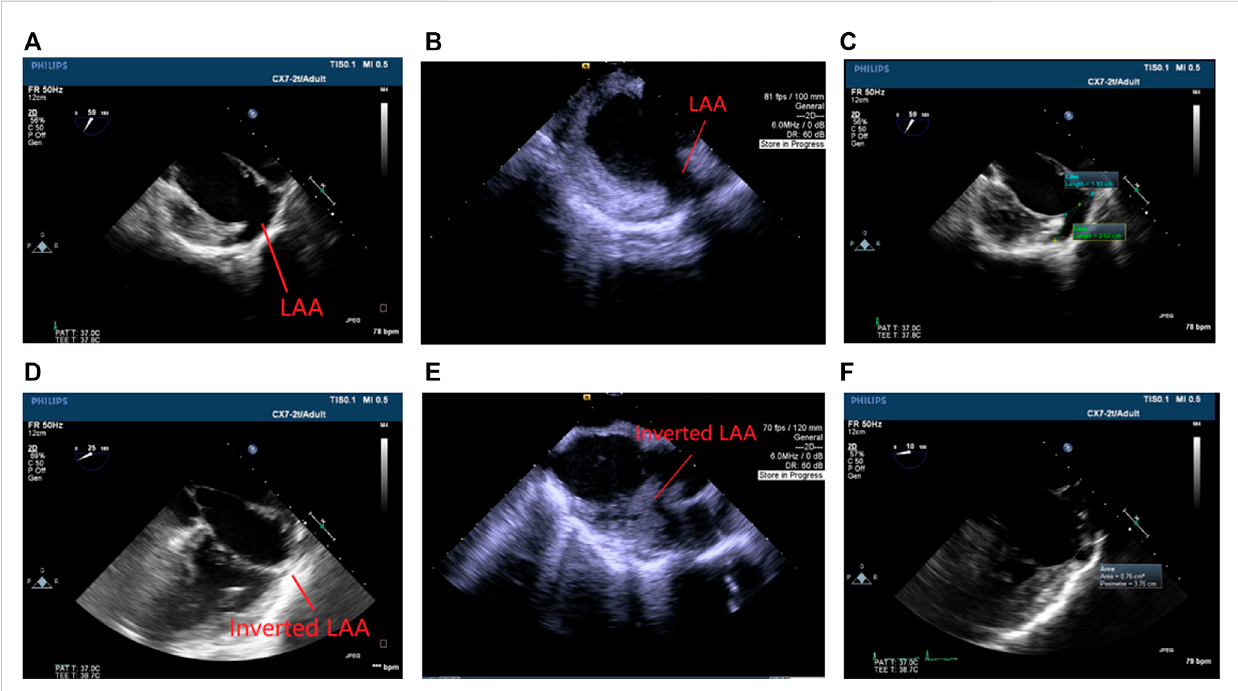
FIGURE 2 Echocardiogram images. (A) TEE before the procedure. (B) ICE before the procedure. (C) An example of LAA measurement before the procedure (blue: ori fi ce diameter; green: depth). (D) TEEat8weeks after theprocedure. (E) ICEat8weeks after theprocedure. (F) An example ofLAA measurement at termination (white ring: area). The inversion signi fi cantly reduced or eliminated the LAA space.